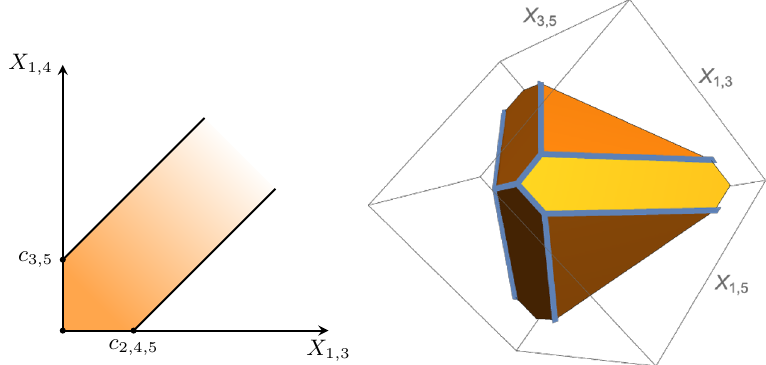
Figure 2 . The left and right geometries are the visualizations of A 5 [(1 , 2) , 3 , (4 , 5)] and A 6 [(1 , 2) , (3 , 4) , (5 , 6)] respectively, taken from ref. [1]. Both geometries are unbounded, and A 5 [(1 , 2) , 3 , (4 , 5)] appears as a facet of A 6 [(1 , 2) , (3 , 4) , (5 , 6)]